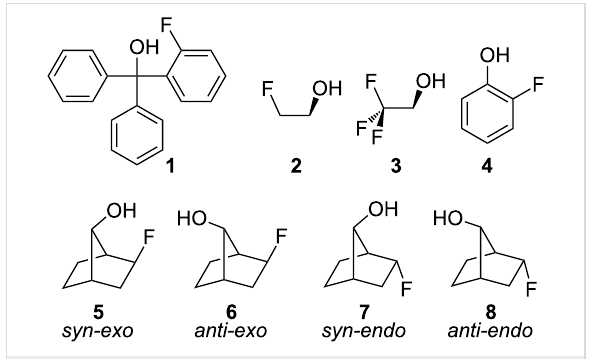
Figure 1: Some organofluorine compounds and the 2-fluorobicyclo[2.2.1]heptan-7-ols ( 5 – 8 ) theoretically studied in this